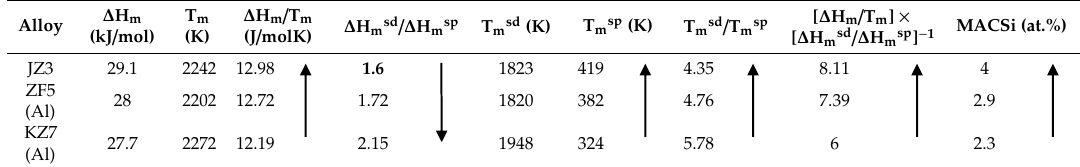
Table 4. Alloy parameters for the macrosegregation of Si in the cast alloys KZ5, KZ6, JZ3, OHS1.